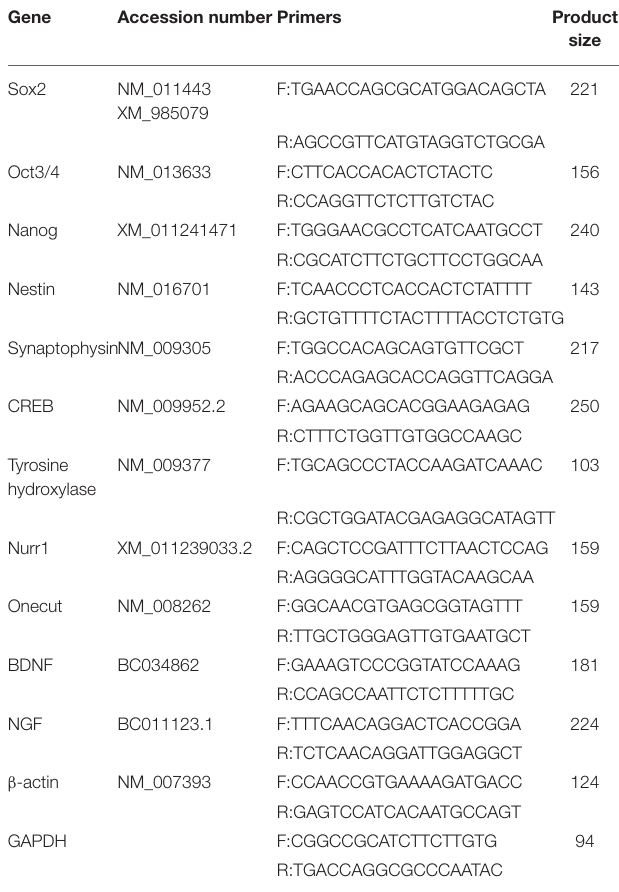
TABLE 1 | Real time PCR primer